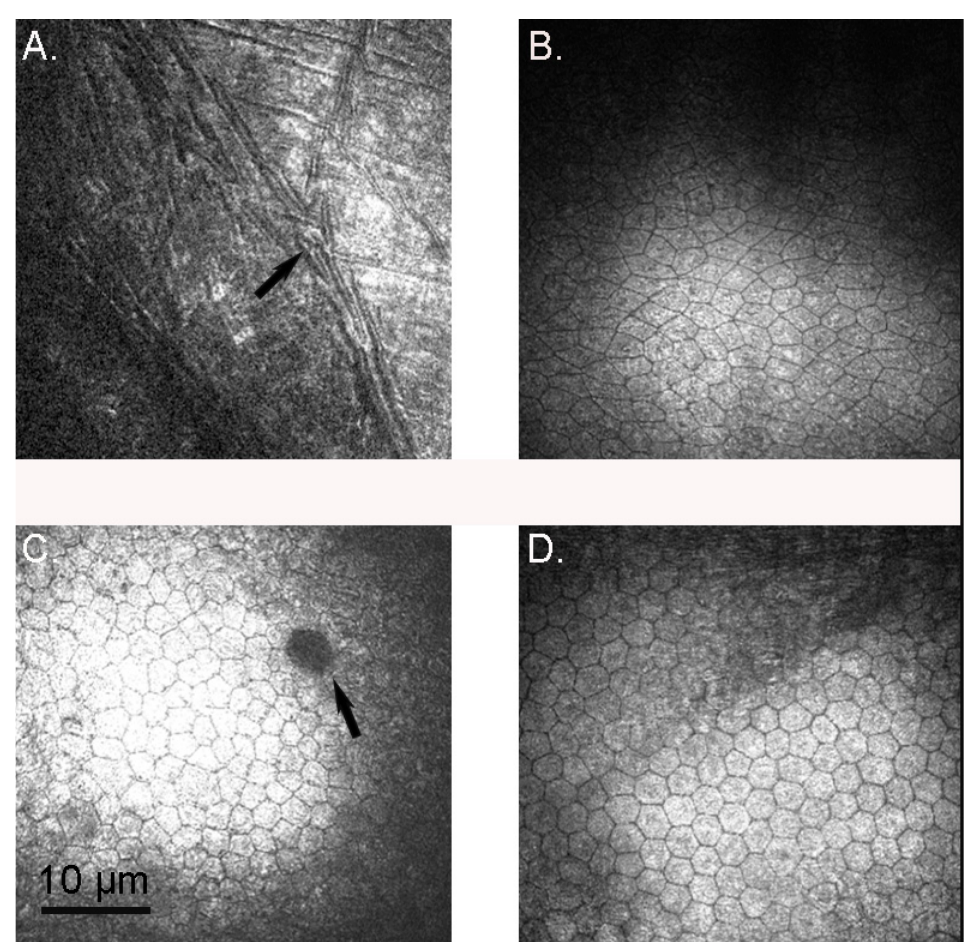
Figure 3. Descemet’s membrane and the corneal endothelium. ( A ) Descemet’s membrane, king penguin Aptenodytes patagonicus K2, left eye. The imprint of stromal morphology, either stromal cells or collagen bands, adjacent to the membrane was clearly visible (arrow); ( B ) Corneal endothelium, little penguin Eudyptula minor L1, left eye. Note the non-hexagonal nature of the cells; ( C ) Corneal endothelium, gentoo penguin Pygoscelis papua G2, left eye. The cells of this 26-year-old penguin were more regular and some are hexagonal, but many were not. There was a dark spot (arrow) which resembled human cornea guttata, more common with increasing age; ( D ) Corneal endothelium, king penguin Aptenodytes patagonicus K2, right eye. This 26-year-old penguin had an endothelium with a regular hexagonal pattern that was indistinguishable from the